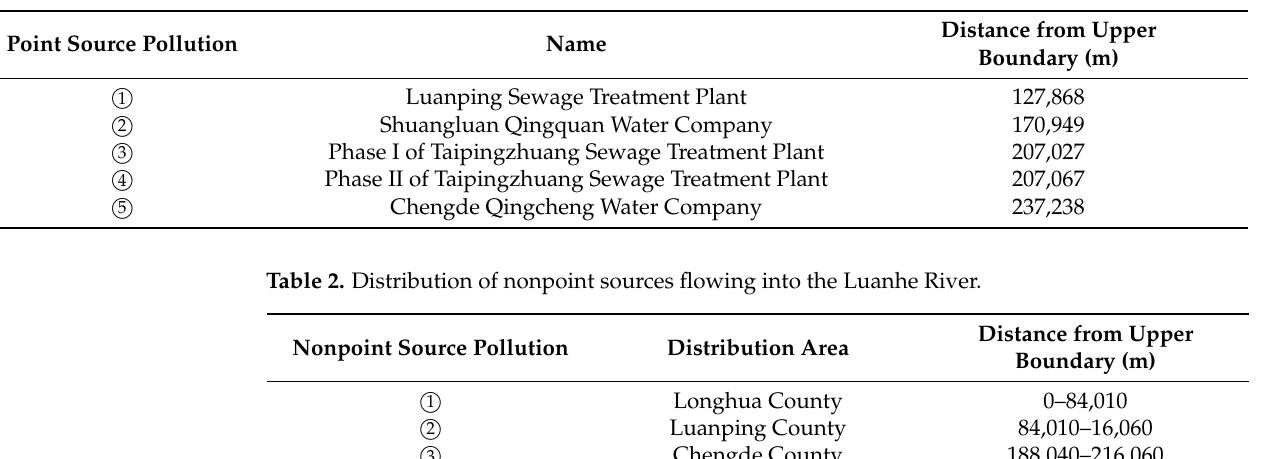
Table 1. Major sewage treatment plants discharged into the Luanhe River.